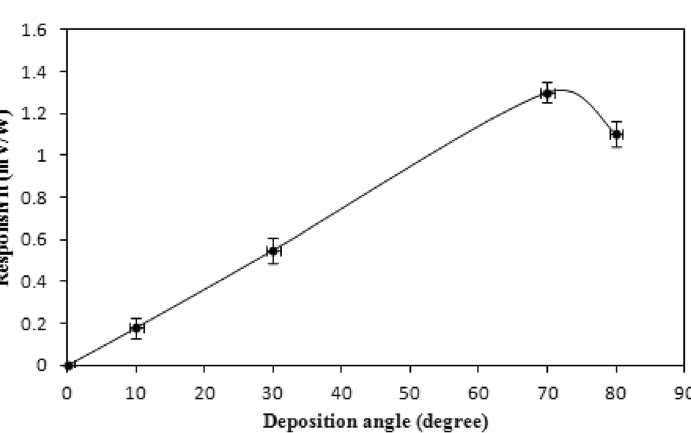
Figure 8. Responsivity of the Sb detector for ruby laser as a function of deposition